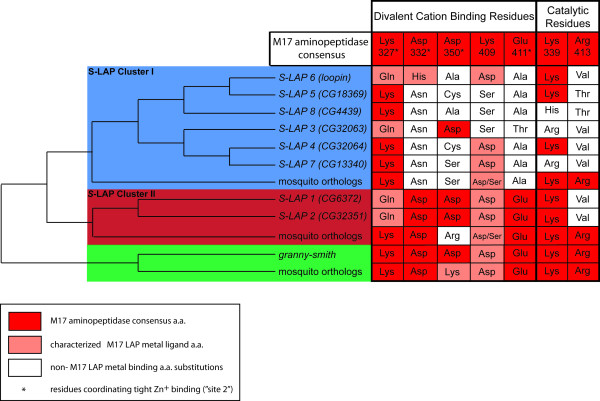
S-LAP divergence at divalent cation binding and catalytic residues. Amino acid composition at the seven residues involved in metal ion binding and catalytic residues is displayed according to the S-LAP phylogeny presented in Figure 1. For cation binding sites, residues matching the M17 leucyl aminopeptidase consensus are highlighted in red, substitutions to other metal binding amino acids in M17 leucyl aminopeptidases are highlighted in pink and substitutions to non-M17 leucyl aminopeptidase metal binding residues in white. For catalytic residues, residues matching the M17 leucyl aminopeptidase consensus are highlighted in red and those divergent from the consensus in white. Amino acid residues Lys327, Asp332, Asp350 and Glu411 comprise the tight, Zn2+-specific binding (site 2), while residue 409 is involved in loose coordination of divalent cations (site 1).